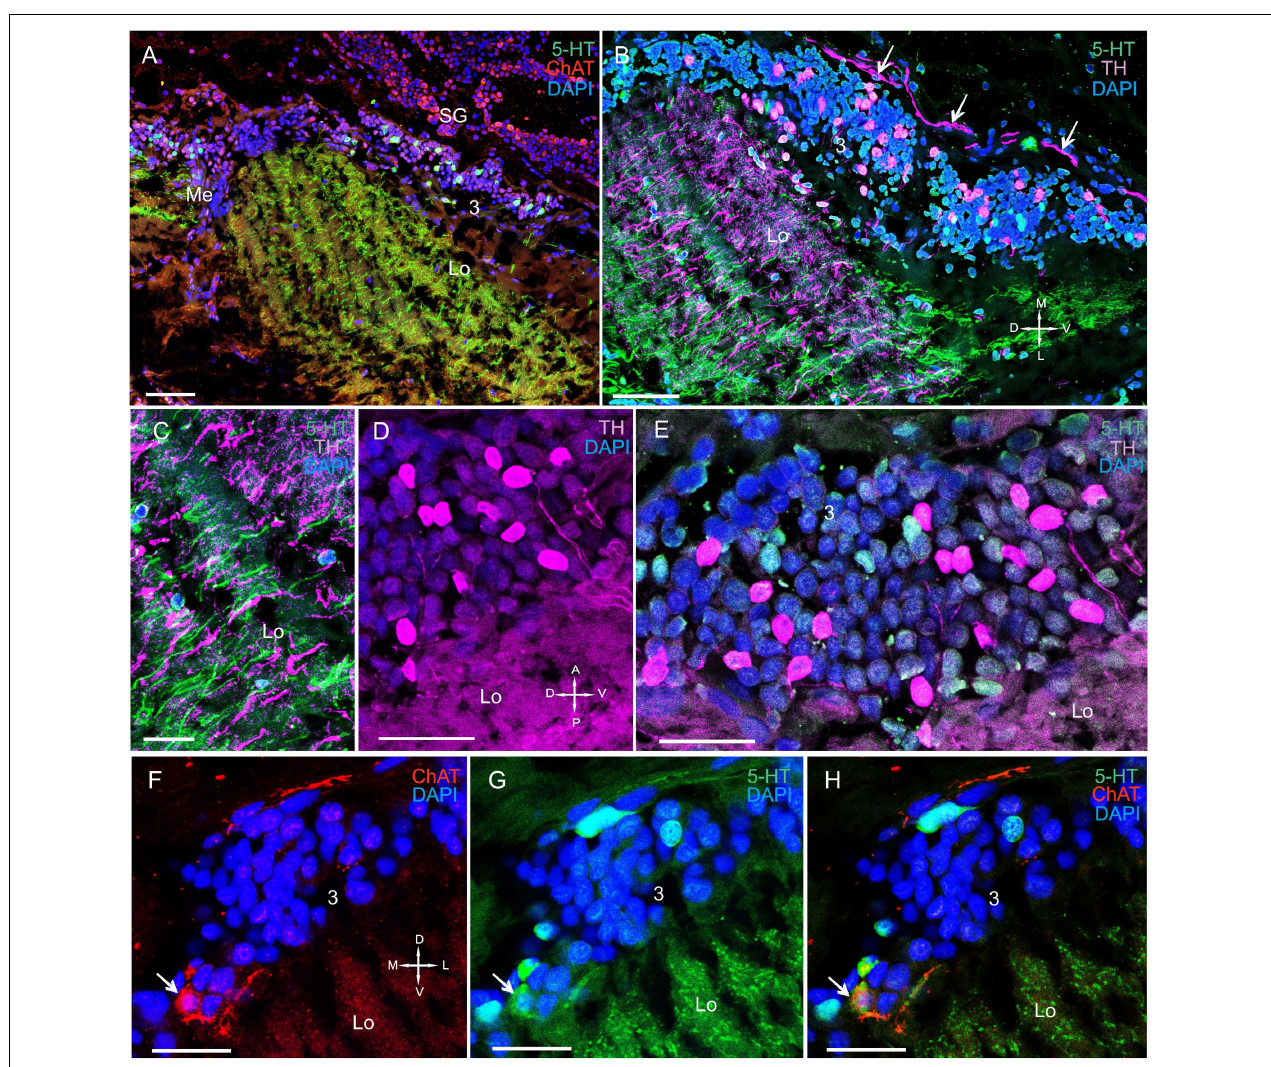
FIGURE 7 | Immunolocalization of 5-HT, TH, and ChAT in the lobula. (A) 5-HT- and ChAT-positive cell bodies and nerve fibers in the Lo. (B) TH- and 5-HT-positive cell bodies and nerve fibers in the Lo with TH-positive fibers running above cell cluster 3. (C) TH-and 5-HT-positive fibers of the Lo. (D) Immunohistochemical localization of TH in the somata of cell cluster 3. (E) Immunohistochemical localization of 5-HT- and TH-positive neurons of cell cluster 3. (F–H) Double immunolabeling of ChAT and 5-HT in cell cluster 3 of the distal part of the Lo. Arrows indicate co-localization of 5-HT with ChAT in neurons. Green, 5-HT; red, ChAT; magenta, TH; blue, DAPI. Scale bars = (A–C) 100 µ m and (D–H) 50 µ